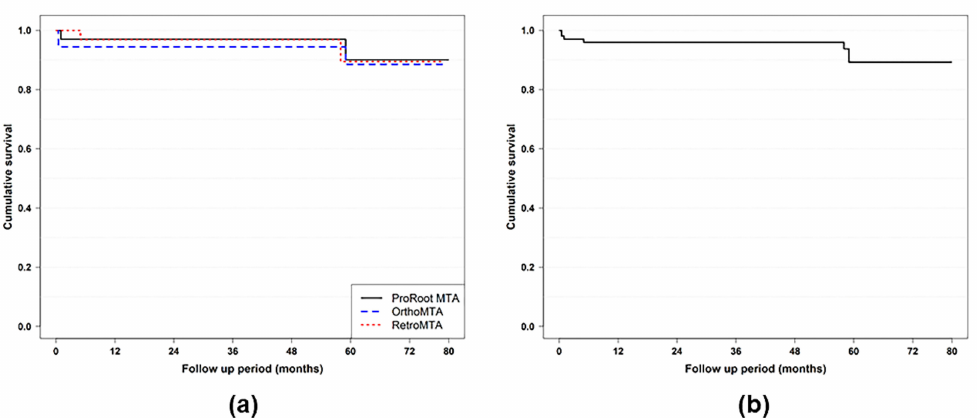
Figure 2. Kaplan–Meier curves of failure-free outcomes in partial pulpotomy using three hydraulic silicate cements. ( a ) The cumulative rates suggest that there was no significant difference between the three tested materials. ( b ) The overall success rate of HSC partial pulpotomy was